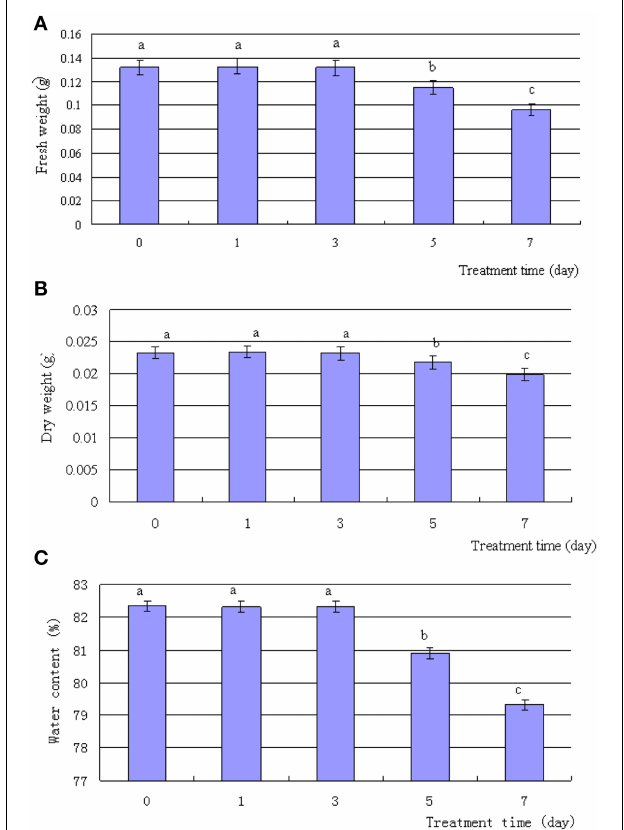
FIGURE 2 | Effects of salinity stress on the weight and water content of T. Nitraria leaves. T. Nitraria seedlings were treated with 500mM NaCl for 0 (control), 1, 3, 5, and 7 days. The changes in fresh weight, dry weight, and water content of the leaves are also shown ( A , B , and C , respectively). The values are presented as means ± standard error (SE); n = 6 for all groups. The bars represent the SE. Bars with the same letter are not significantly different ( P < 0 . 05).